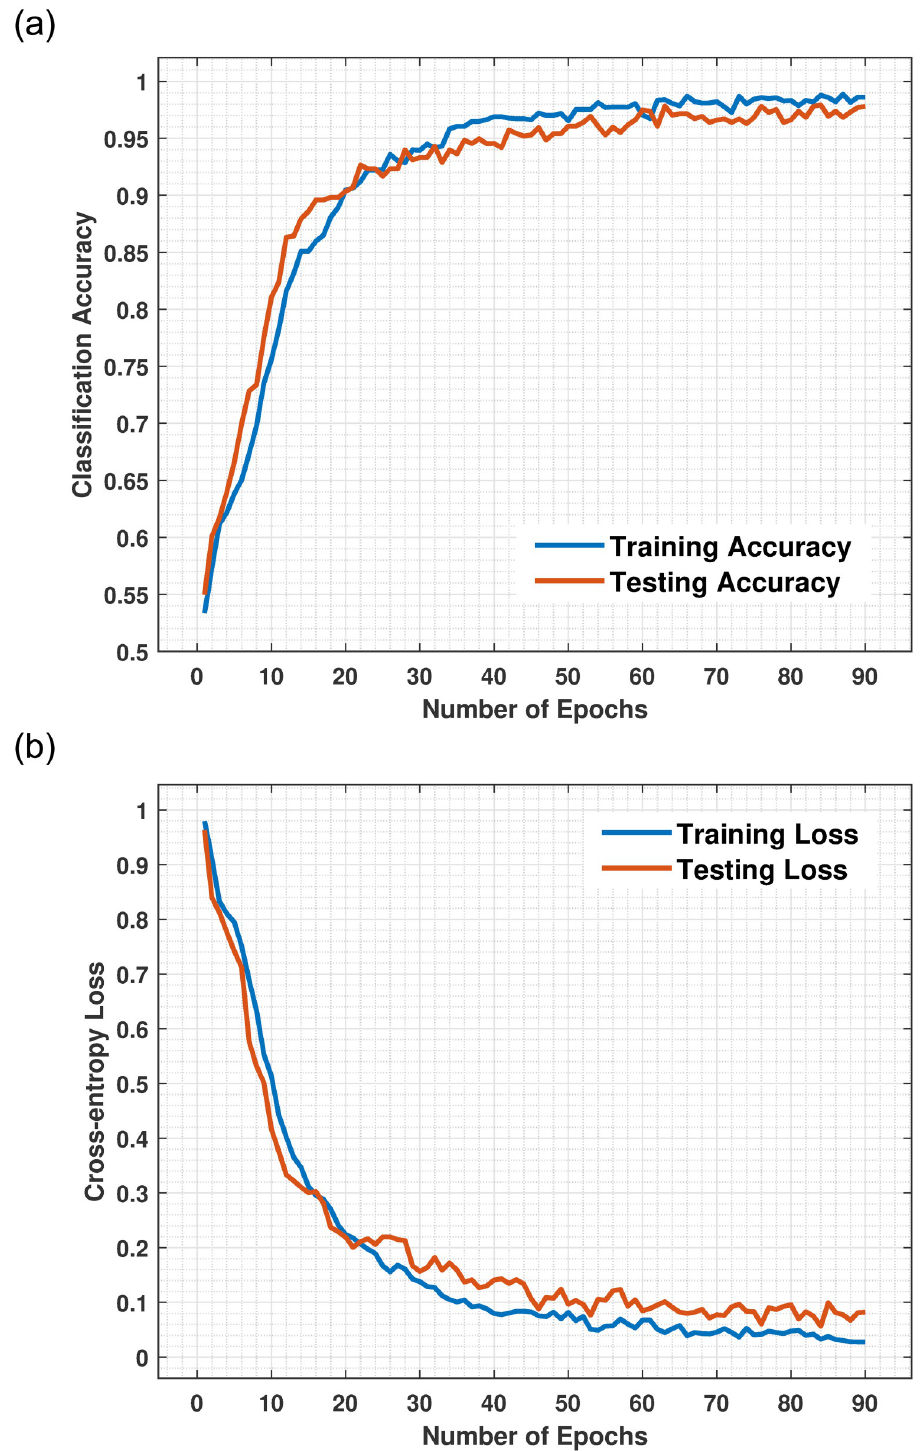
Fig 5. (a) Represent the training and testing accuracy of the proposed model against the training step using a Private dataset. The training accuracy scaled up on each epoch and after the 90 th epoch was 0.98 which other models outperform. (b) Represent training and testing cross-entropy loss of the proposed model against the training step using Private dataset. The proposed model generates reduced false-negative results compared to existing DCNN models. The training cross-entropy loss function is declining continuously on every epoch and reduced to a minimum equal to 0.068 at the last epoch.